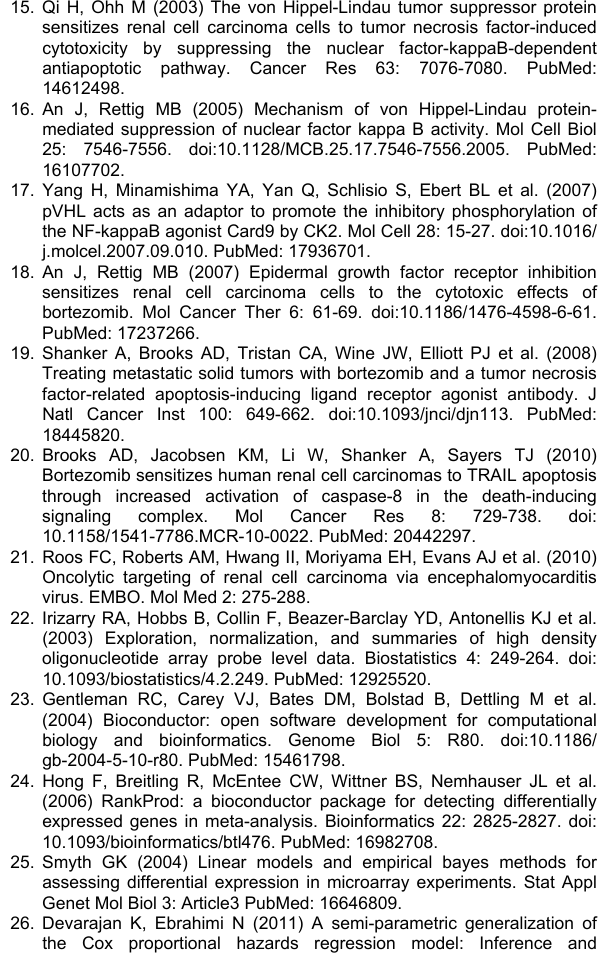
Table S1. Datasets used in this study.